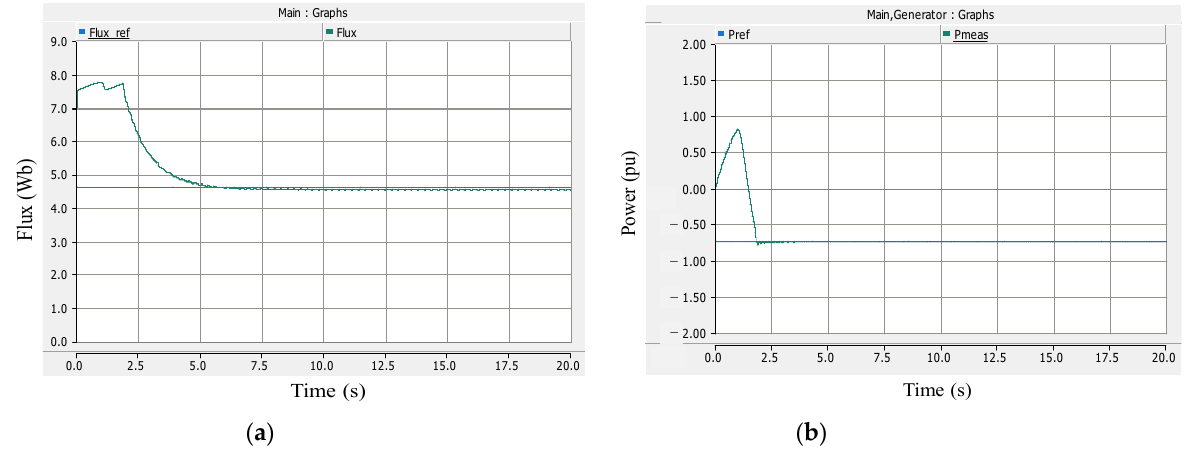
Figure 18. ( a ) Flux control; ( b ) power control at 0.9 pu rotor speed.